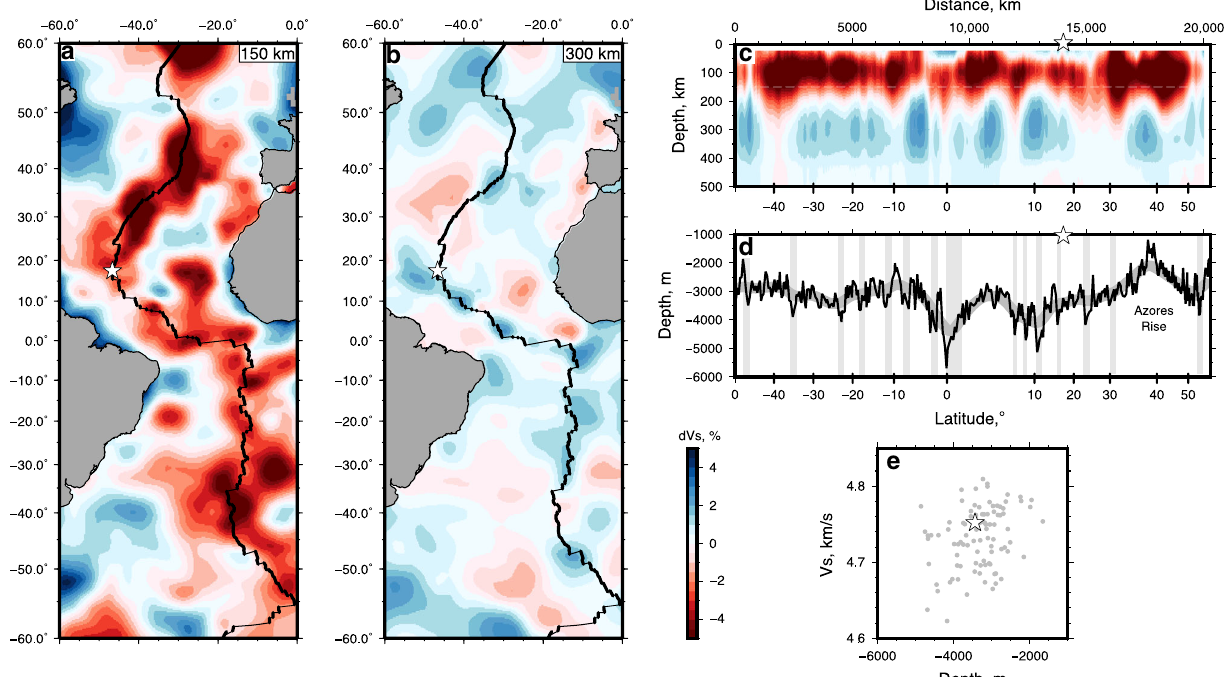
Fig. 5 Shear wave velocity structure beneath the Mid-Atlantic Ridge. a , b Horizontal slices through SL2013sv shear velocity tomographic model where percentage anomaly (dV s ) is with respect to AK135 model at 150 and 300 km, respectively 53 ; thick/thin black lines are spreading segments/fracture zones, respectively 69 . Stars denote 16°N segment. c Vertical slice along MAR shown in a , b ; gray bands are major fracture zones, star is 16°N segment. d Black/gray line is ridge depth smoothed with 2000km Gaussian fi lter. e Ridge depth smoothed with a 280 km Gaussian fi lter, compared with V s (gray dots) along the MAR between 50°S and 55°N; star is 16°N segment.